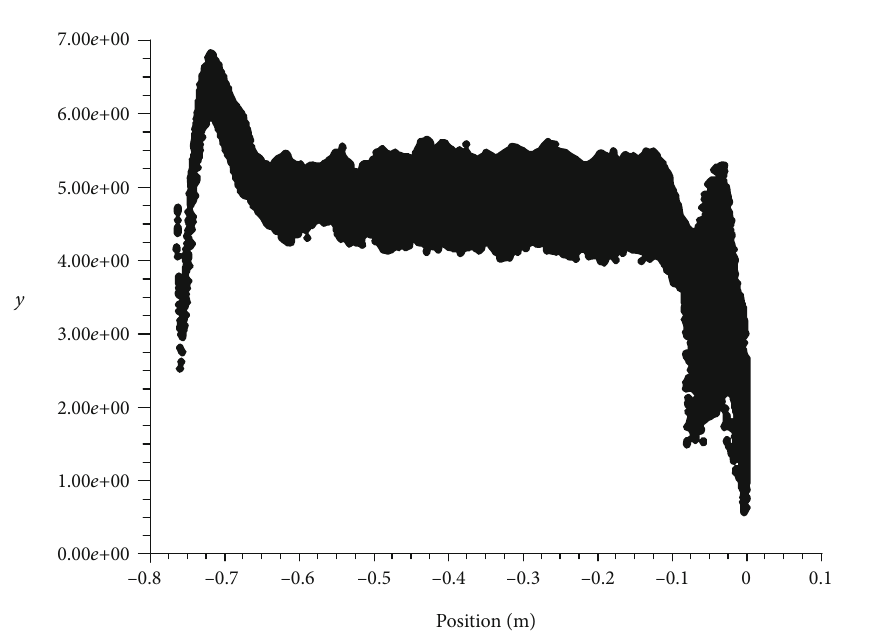
Figure 3: y + value for the missile